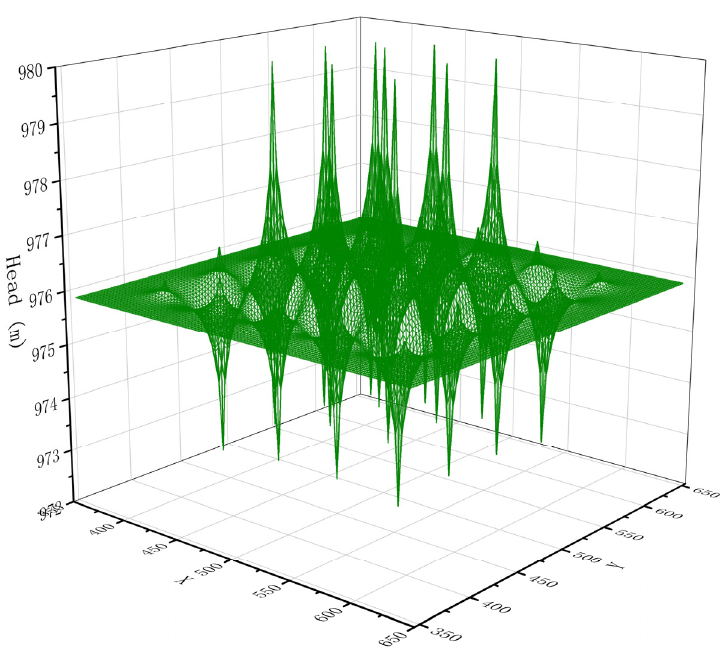
Figure 4. Water level contour map of the in-situ leaching mining area.